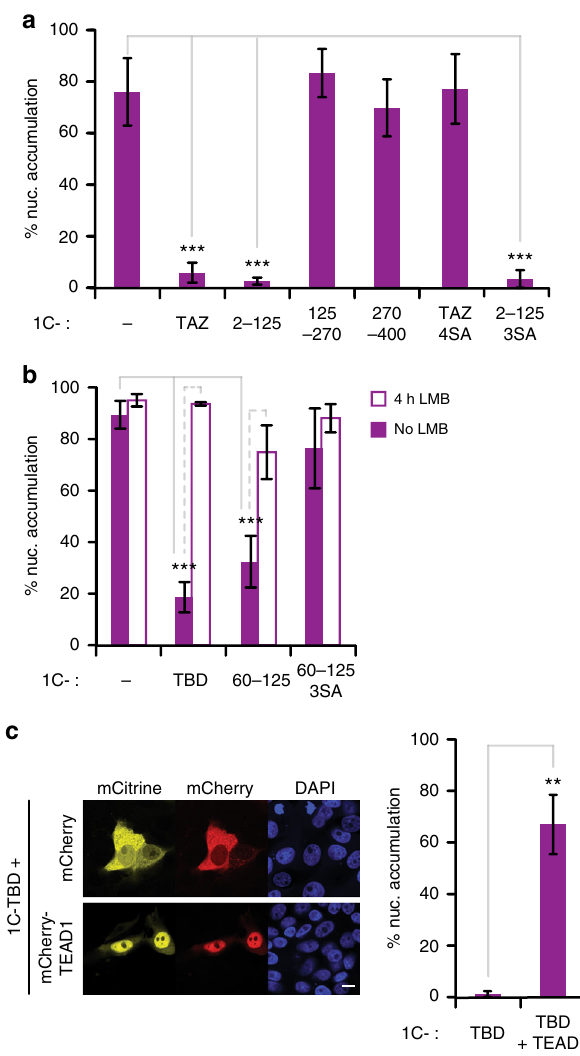
Fig. 7 The TEAD-Binding Domain (TBD) mediates cytoplasmic accumulation. a Nuclear accumulation of 1C, 1C-TAZ, or 1C-tagged TAZ fragments, n = 4. b Nuclear accumulation of 1C-tagged TBD (2 – 60) and 14 – 3 – 3 binding region (60 – 125) with or without 4h LMB treatment, n = 4. c TEAD-induced nuclear accumulation of the TBD. Confocal fl uorescence microscopy images of 1C-TBD (yellow), co-expressed with mCherry or mCherry-TEAD1 (red). Nuclei were visualized by DAPI staining (blue). Scale bar: 10 μ m. Quanti fi cations are shown on the right, n = 4. Data are represented as means± SD. ** p < 0.01, *** p < 0.001; Student ’ s t